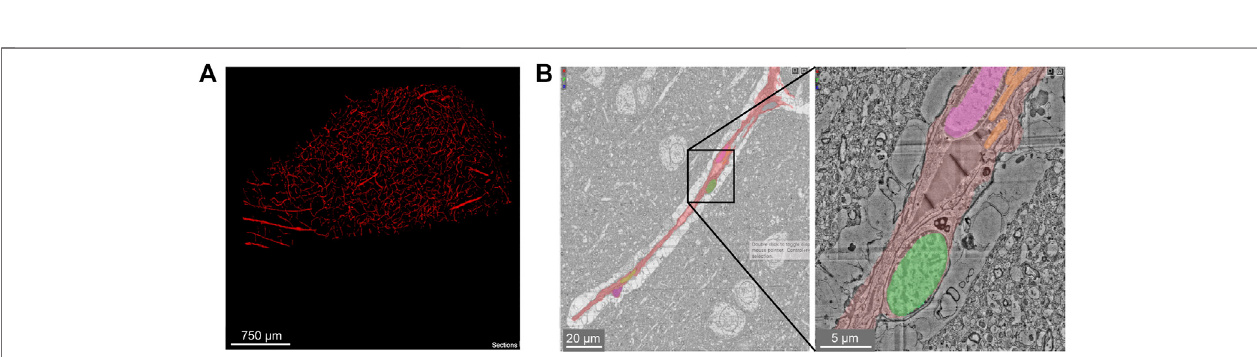
FIGURE 13 | Human cerebral cortex microvasculature. (A) Broad view of the microvasculature captured in the data set of Shapson-Coe et al . (B) A capillary-sized vesselshowinggeneralsegmentationofthevasculature.Thenucleiofvascularcellswereseparatelysegmentedintopericytesorendothelialcells,basedontheirlocation relative to the blood vessel lumen and basement membrane layers, as well as their appearance in EM. In the example shown, the pericyte nucleus is green and the endothelial nucleus is pink. Left image x, y, z coordinates at: 297270, 74996, 5229. Right image x, y, z coordinates at: 299348, 73663, 5229.